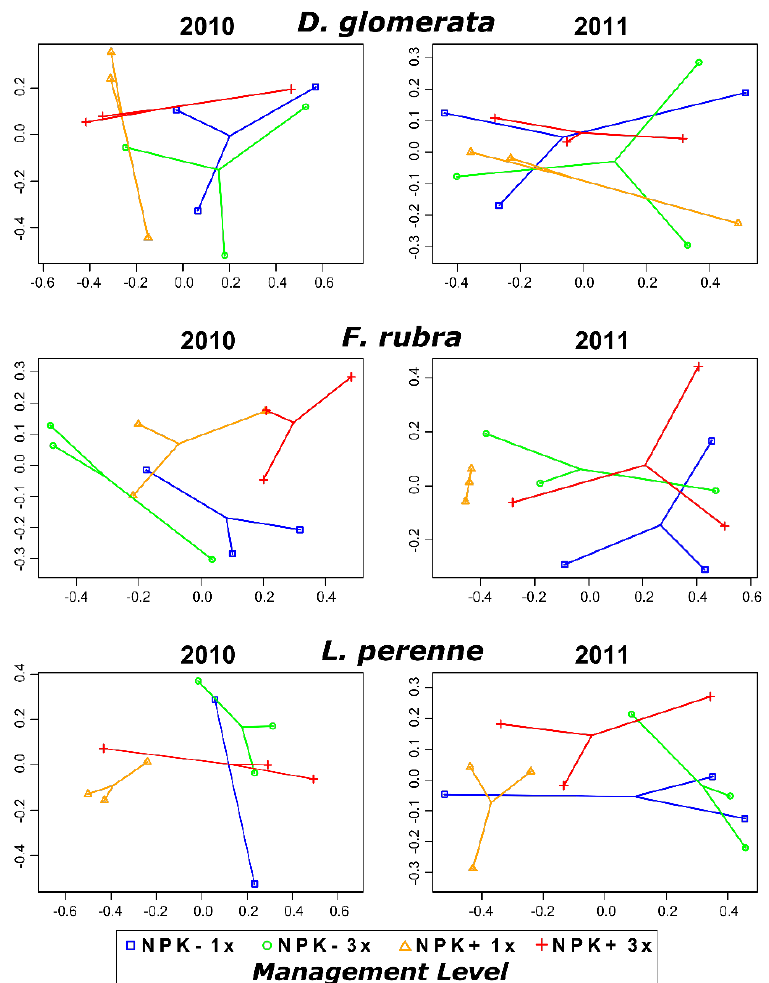
Figure 4. Non-metric multidimensional scaling (nMDS) plots based on Bray-Curtis dissimilarities of fungal endophyte communities in D. glomerata , F. rubra and L. perenne collected in 2010 and 2011. Note